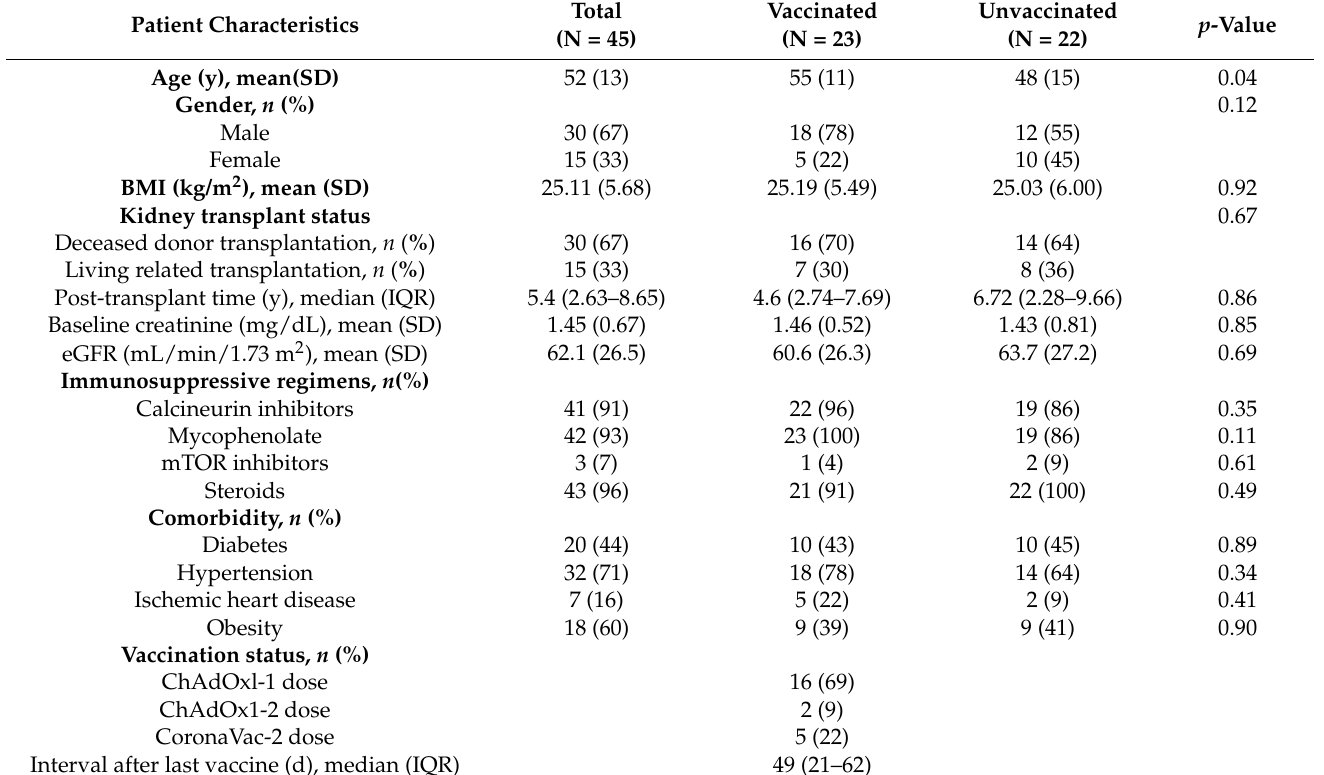
Table 1. Baseline